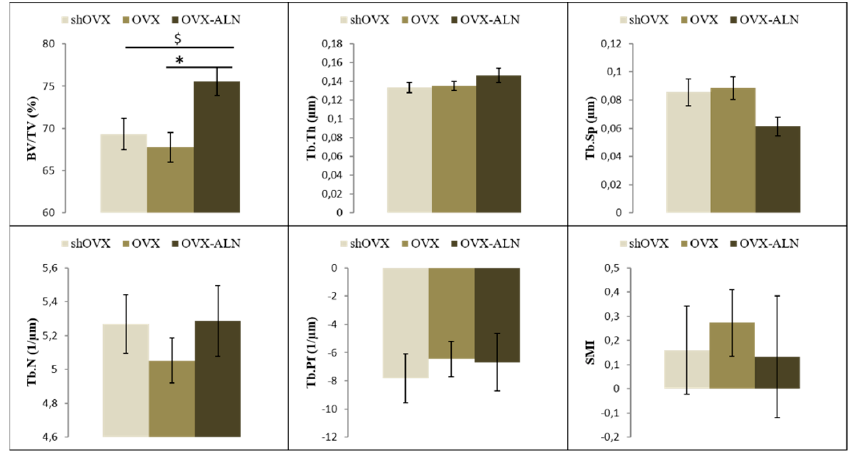
Figure 1. Bar diagrams illustrating the micro ‐ architectural parametric values of the trabecular bone of the second maxillary molar at the inter ‐ radicular septum. #, *, $: Values with the same sign are statistically significantly different, with p < 0.05. BV/TV, bone volume/tissue volume; Tb.Th, trabecular thickness; Tb.Sp, trabecular spacing; Tb.N, trabecular number; Tb.Pf, trabecular pattern factor; SMI, structure model index; shOVX, sham-ovariectomy surgery; OVX, ovariectomy surgery; OVX-ALN, OVX group treated with the anti-resorptive bisphosphonate drug alendronate sodium trihydrate.